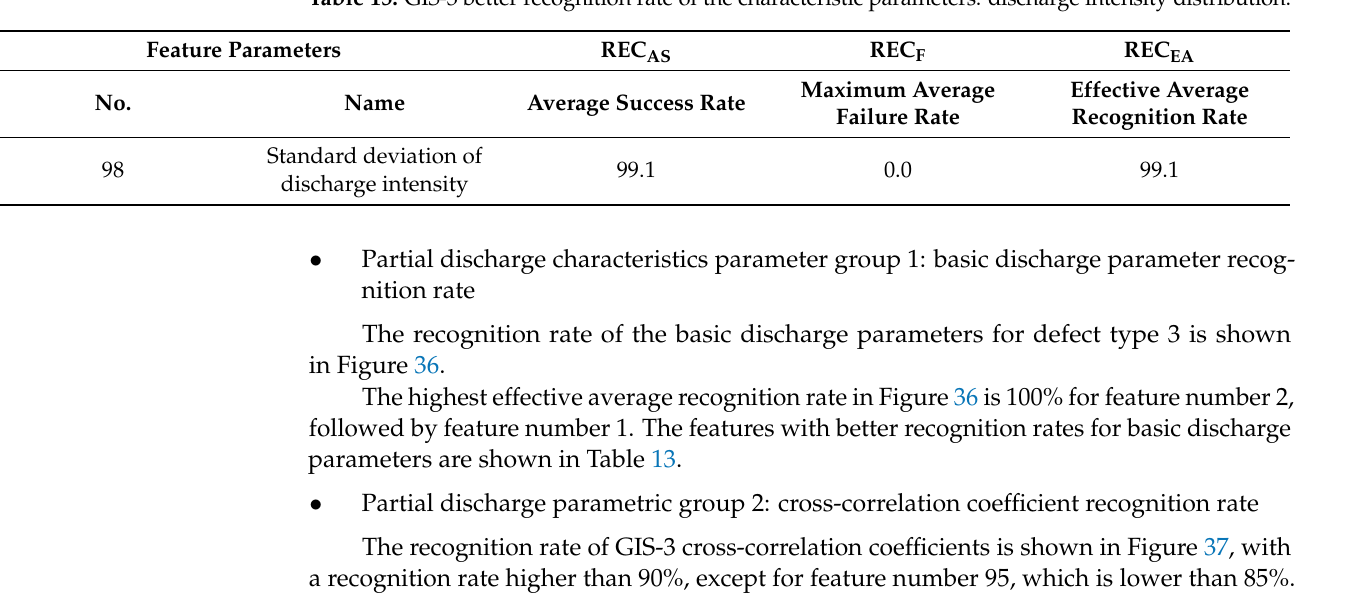
Table 15. GIS-3 better recognition rate of the characteristic parameters: discharge intensity